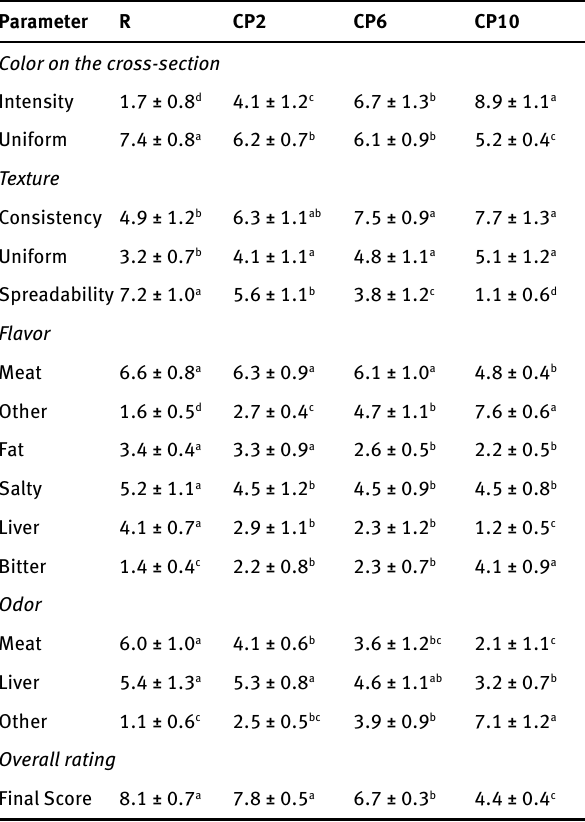
Table 3: Results of sensory study